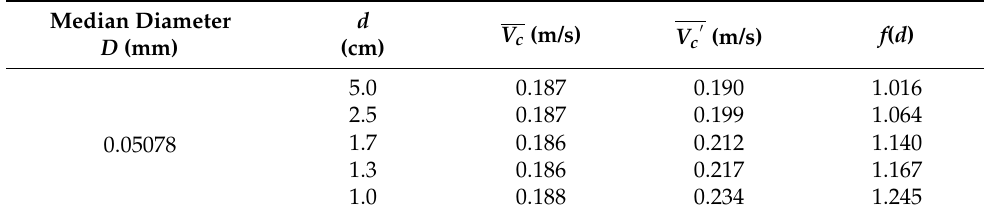
Table 2. Reinforcement spacing and reinforcement coefficient.